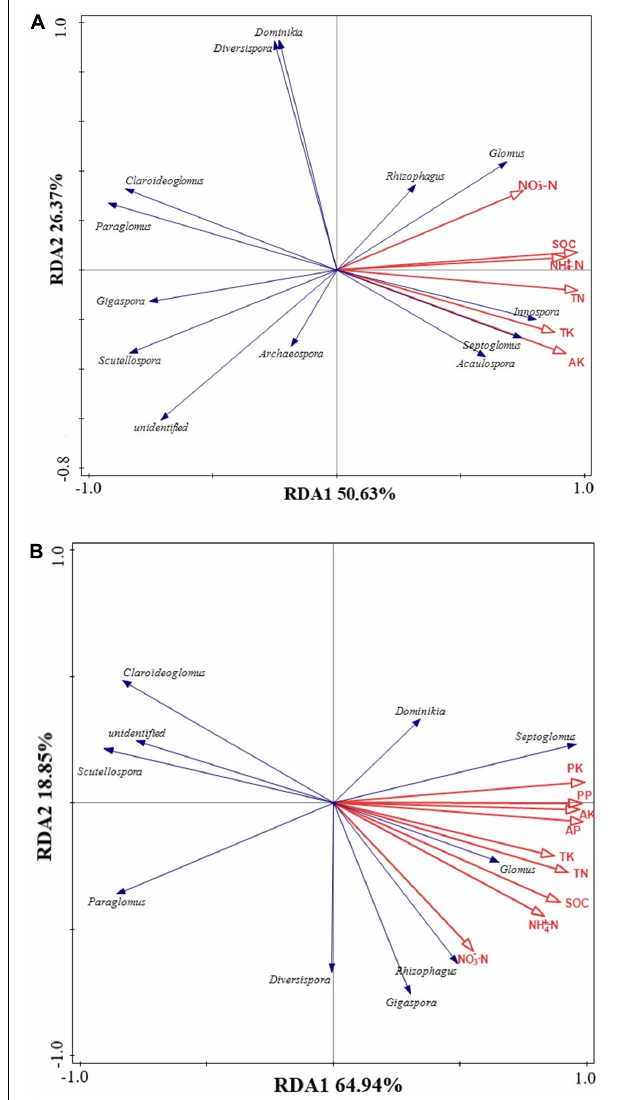
FIGURE 6 | Redundancy analysis (RDA) of AMF communities in soils (A) and roots (B) in response to different fertilizer applications. NH 4 + -N, ammonium nitrogen; NO 3 - -N, nitrate nitrogen; AP, available phosphorus; AK, available potassium; SOC, soil organic carbon; TN, total nitrogen; TP, total phosphorus; TK, total potassium; PP, plant phosphorus content; PK, plant potassium